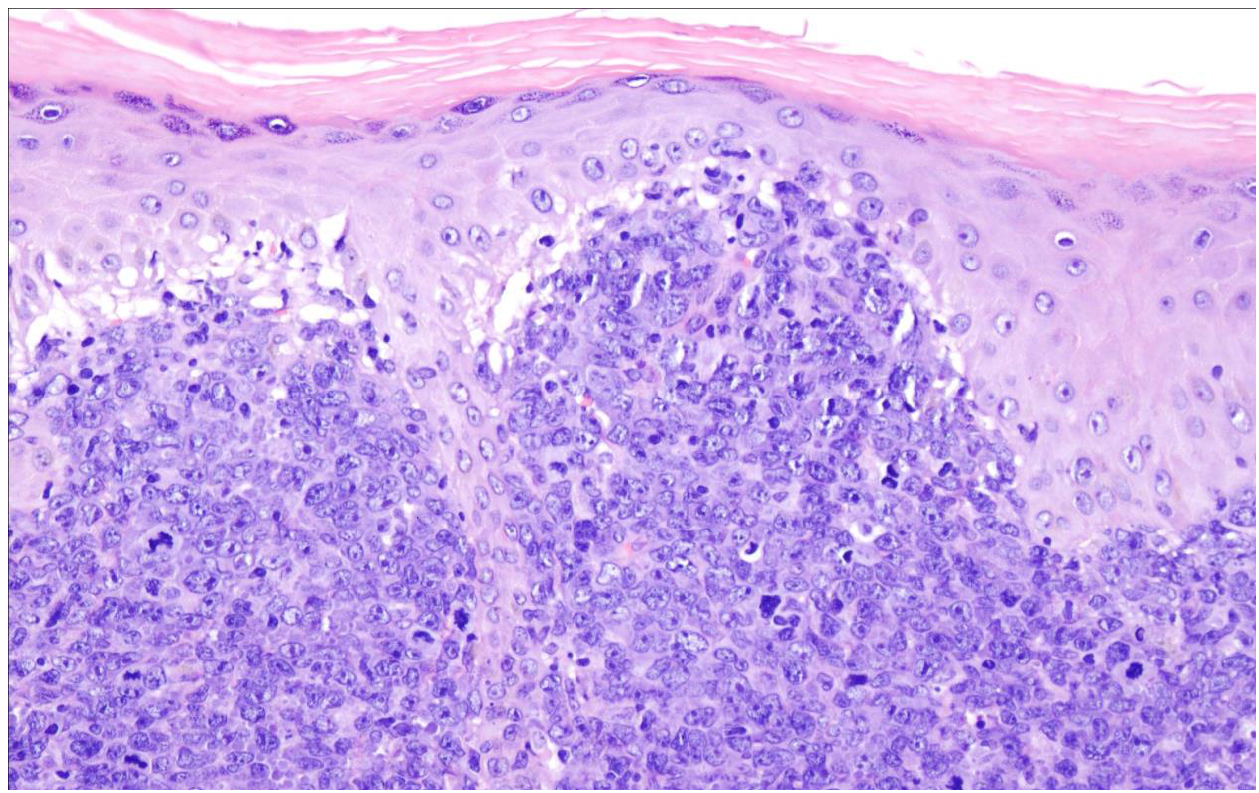
Figure 12. Primary cutaneous diffuse large B-cell lymphoma, leg type (H&E ×200). The large blastic tumor cells are invading the skin and reach the overlying epidermis.